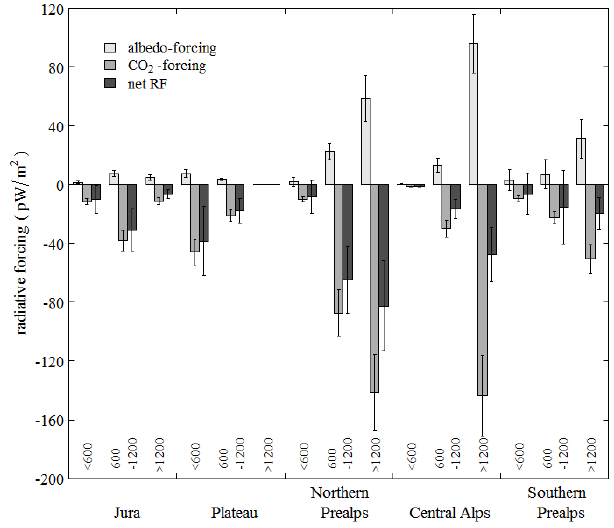
Figure 5. Radiative forcings of the forest expansion between 1985 and 1997 for three elevations in the biogeographical regions Jura, Plateau, northern Prealps, Central Alps and southern